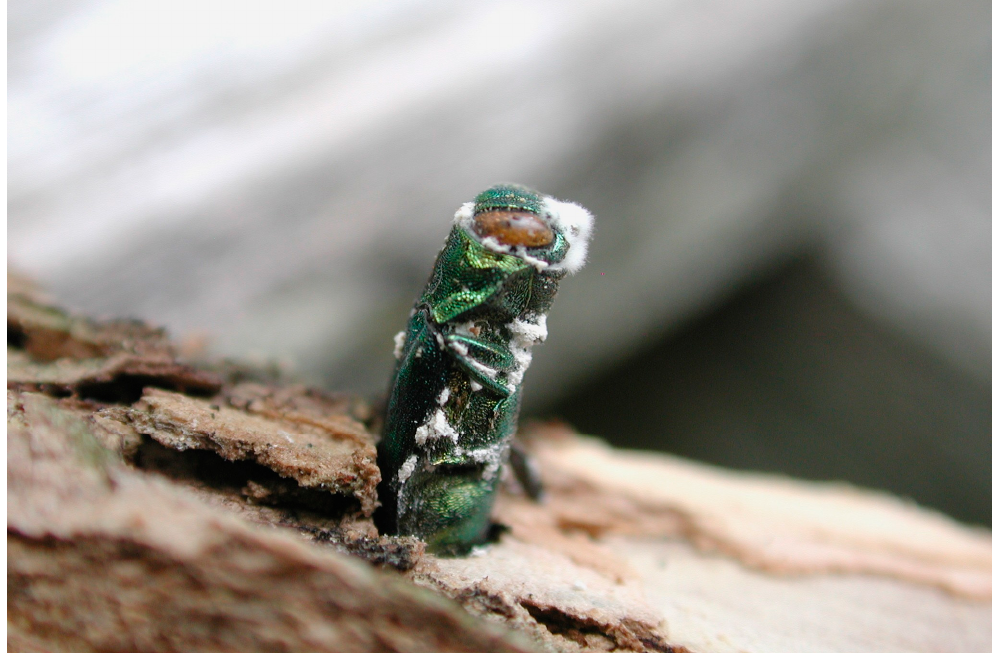
Figure 5. Adult of Agrilus planipennis infected with Beauveria bassiana as a result of pre-emergence field cage trials.